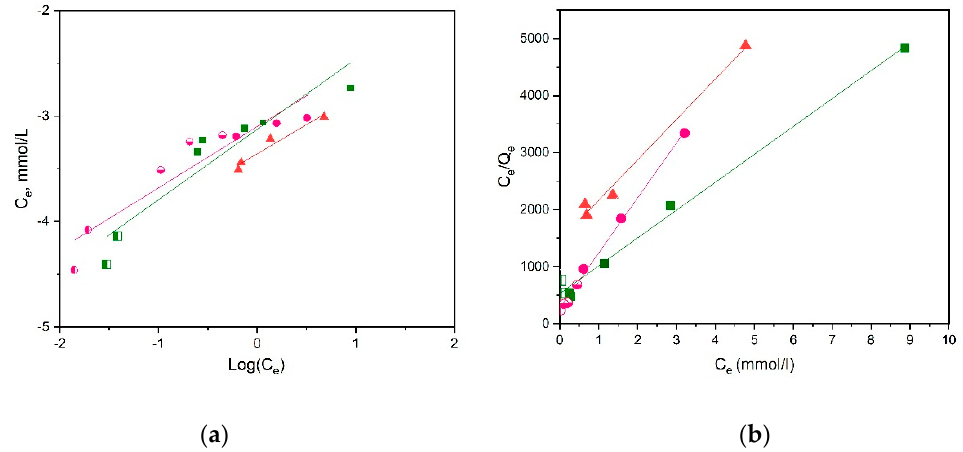
Figure 12. Freundlich ( a ) and Langmuir ( b ) isotherm models for the adsorption of Cu 2+ for the studies reported in Figure 11.